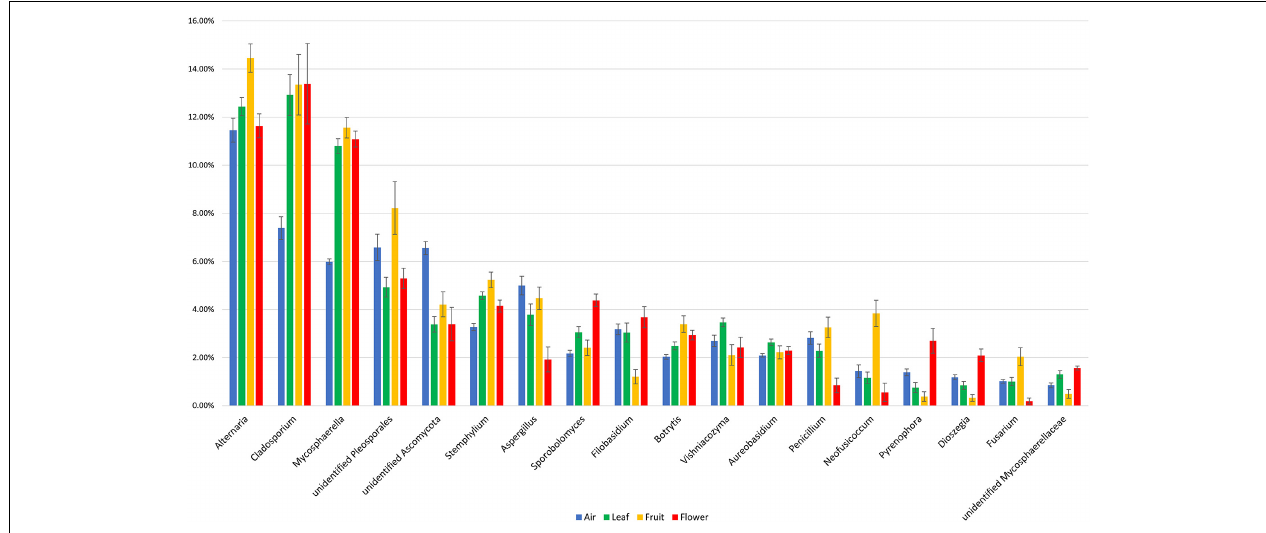
using FDR method ( Supplementary Table S2